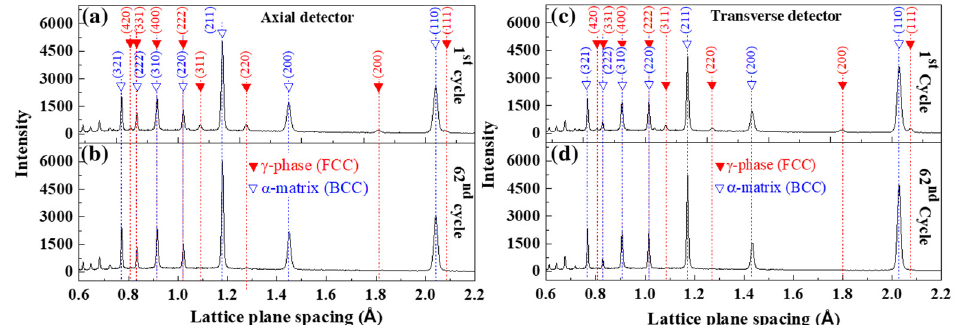
Figure 2. In-situ neutron-diffraction profiles at the maximum tensile strain of 1.0% in the axial loading direction at the ( a ) 1st cycle and ( b ) 62nd cycle. Those in the transverse direction at the ( c ) 1st cycle and ( d ) 62nd cycle in the SLM-built 15-5 PH steel.